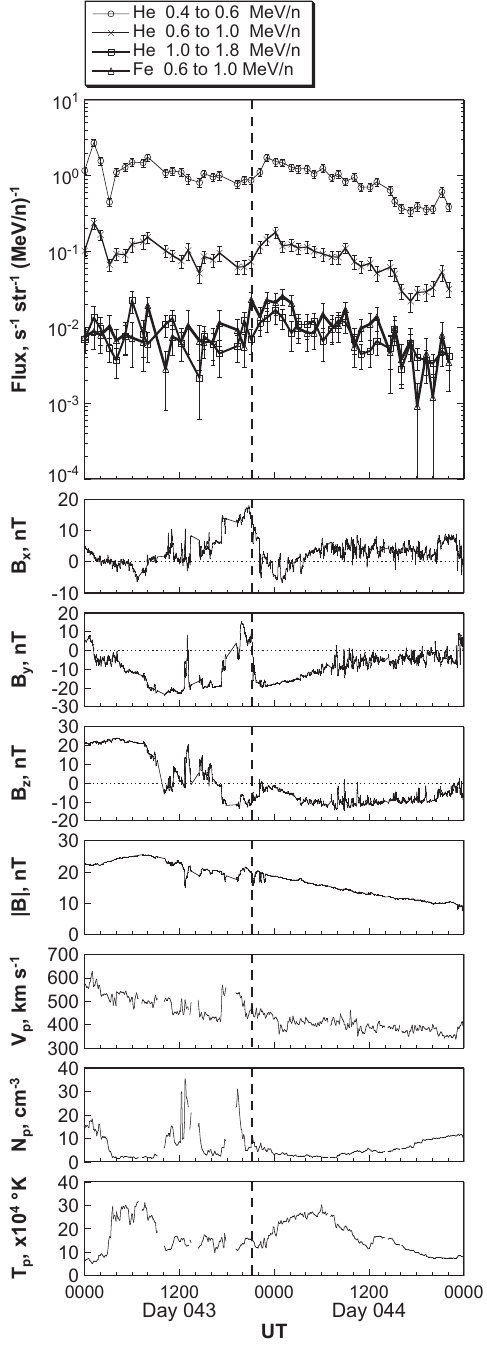
Fig. 6. He ( 3 He+ 4 He) flux, plasma and magnetic field data for the 12 February 1982 event.